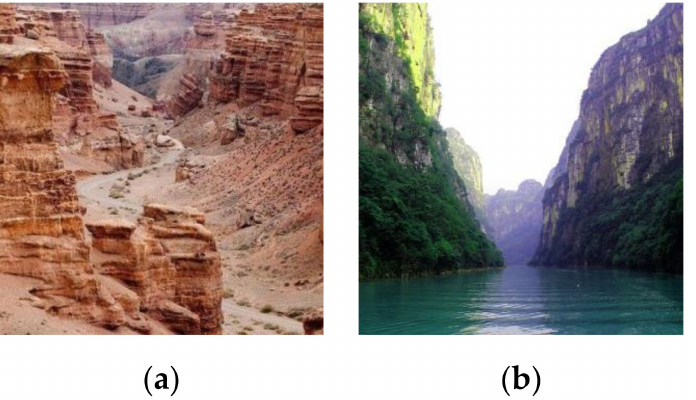
Figure 1. Natural canyon and valley environment: ( a ) canyon with terrestrial bottom; ( b ) valley with water